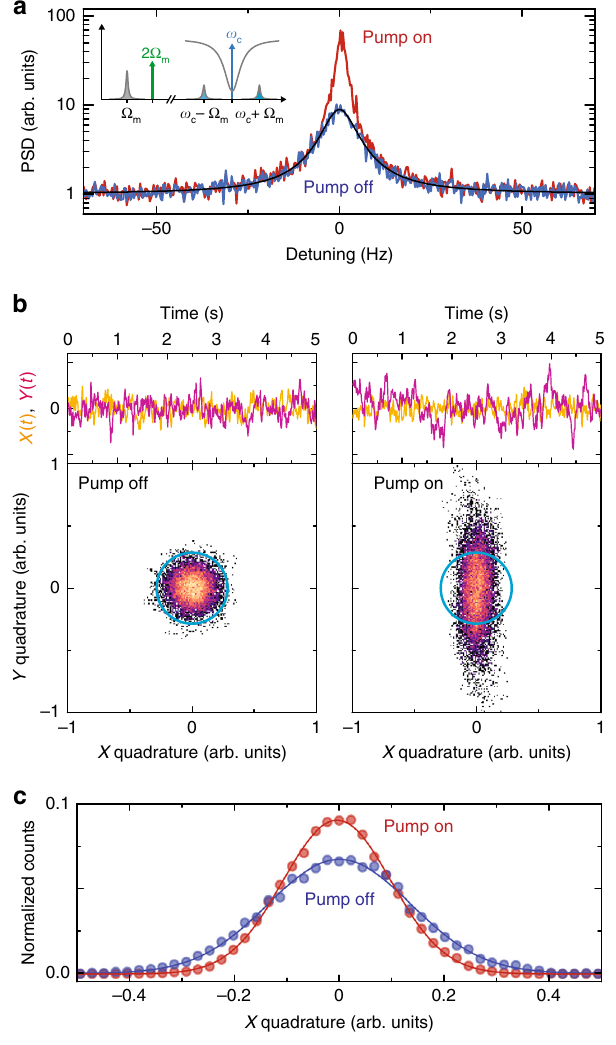
Fig. 3 Interferometric detection of squeezed thermomechanical noise in a nanomechanical oscillator. a The thermal displacement fl uctuations generate sidebands at ω = ω c + Ω m and ω = ω c − Ω m to a microwave tone sent to the cavity at ω = ω c as schematically shown in the inset. After down-conversion, we detect these sidebands and the corresponding power spectral density is shown for the parametric modulation switched off as blue line and with the parametric modulation switched on as red line. The black line is a Lorentzian fi t to the data without parametric modulation. b shows the quadratures of the thermal displacement fl uctuations vs. time in the top panels and as histograms (taken for 300 s of measurement time) in the bottom panels. Without parametric modulation, the thermal fl uctuations are distributed equally in both quadratures (left side) and the quadrature histogram is a rotational symmetric Gaussian curve; with a parametric modulation applied, as shown on the right side, the fl uctuations in one quadrature get ampli fi ed while the fl uctuations in the second quadrature get de-ampli fi ed. The result is a squeezed thermal state. The colorscale represents histogram counts from low (dark) to high (orange) values. White pixels correspond to no recorded counts. The blue circles in the histogram plots are guides to the eye. In ( c ) we plot the distribution of X -quadrature values for the histograms shown in ( b ) as dots and Gaussian fi ts as lines. When the parametric modulation is switched on, the variance of the X -quadrature gets signi fi cantly decreased and the squeezing factor is approximately s = 0.49. The histograms are normalized to the total number of ~13,000 data points. Data were taken for V 2 Ω ∕ V t =